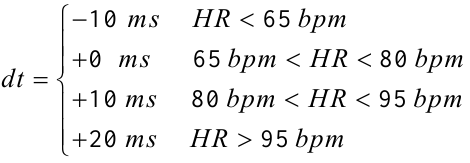
Figure 9. Block diagram of heartbeat normalization